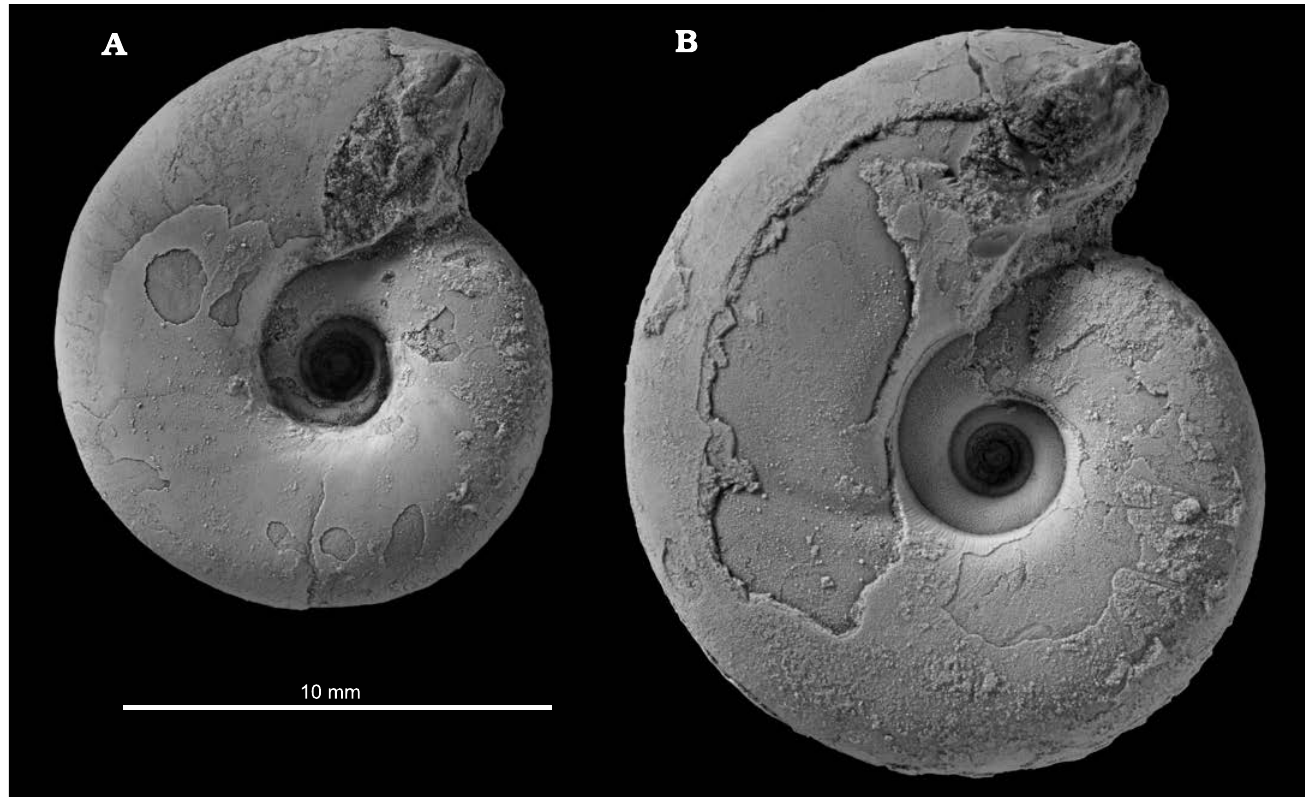
Fig. 2. Photographs of microconch and macroconch in lateral view of tetragonitid ammonoid Tetragonites minimus Shigeta, 1989, from the Santonian, Yezo Group, Horotatesawa Creek (A, outcrop HR001, and B, HR109) the Kotanbetsu area, Hokkaido, Japan. A . MCM-W1560 [m]. B . MCM-W1572